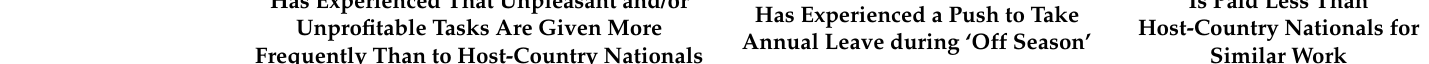
Table 4. Determinants of perceived discrimination: three logistic regression